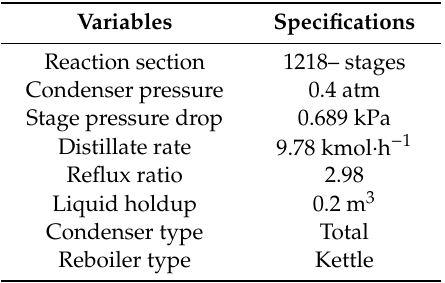
Table 1. Operational conditions of the reactive distillation